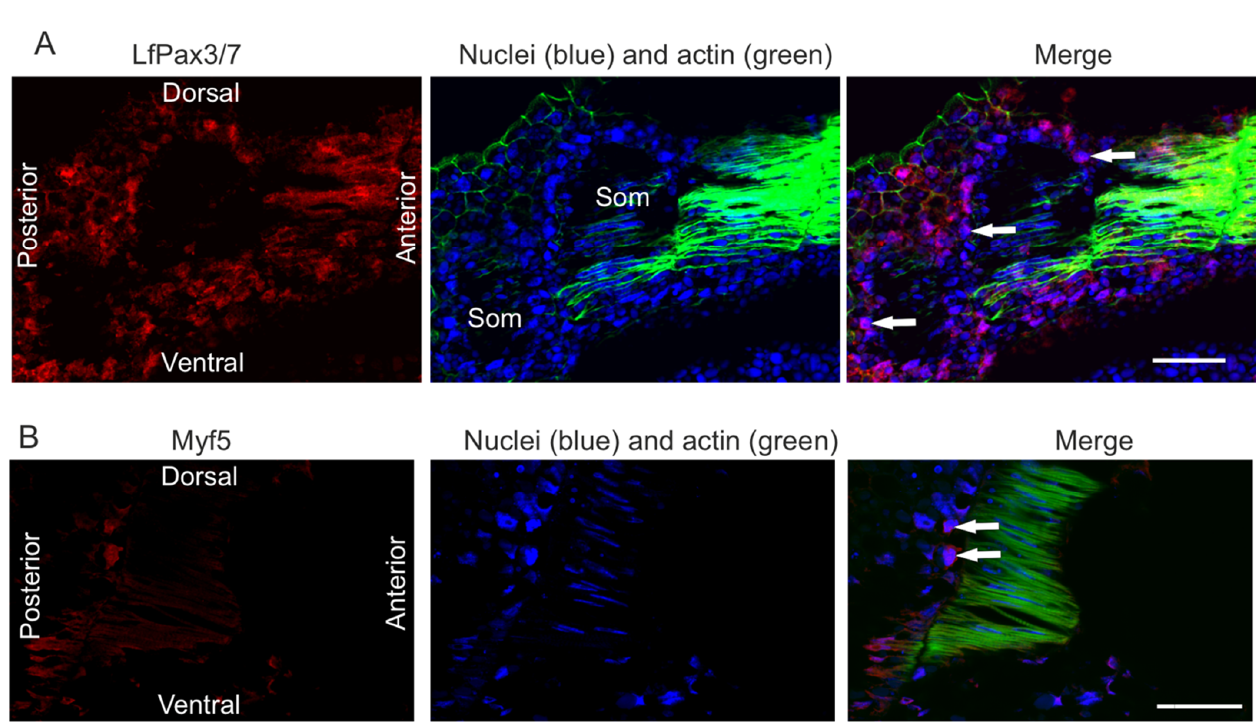
Figure 3. LfPax3/7 and Myf5 presence in the river lamprey ( L. fluviatilis ) dermomyotome. ( A ) Confocal cross section through the trunk muscles (stage XVII). LfPax3/7 (red), nuclei (blue), actin (green). ( B ) Confocal cross section of the trunk muscles (stage XXI). Myf5 (red), nuclei (blue), actin (green). The white arrows point out the LfPax3/7 and Myf5 signal in the nucleus. Somite (Som). Scale: 150 µm.